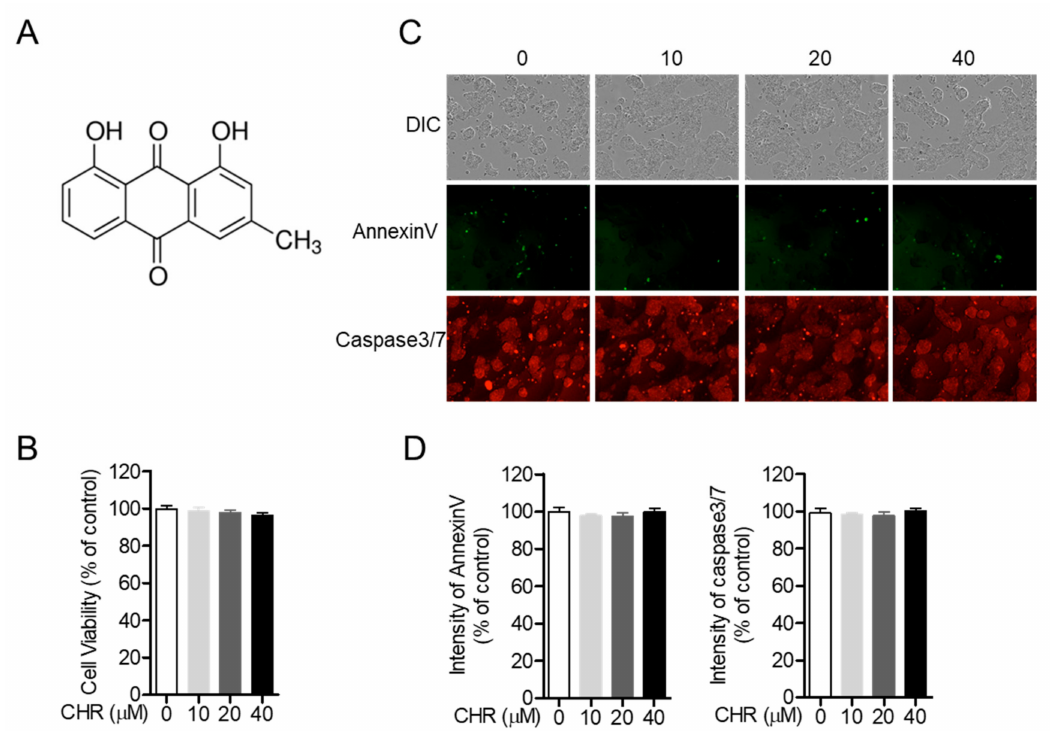
Figure 1. Chrysophanol (CHR) does not show cytotoxicity on HT-29 colorectal cells. ( A ) The chemical structure of chrysophanol. ( B ) HT-29 cells (1 × 10 4 /well, 96-well plate) were treated with the indicated concentrations of chrysophanol (0 to 40 µ M) for 24 h and methyl thiazol tetrazolium (MTT) assay was performed for determination of cell viability. ( C , D ) HT-29 cells (1 × 10 4 /well, 96-well plate) were treated with the indicated concentration (0 to 40 µ M) of chrysophanol for 24 h and the intensity of AnnexinV and Caspase3/7 was assessed by IncuCyte imaging system. Obtained cell images ( C ) and intensity of AnnexinV or Caspase3/7 is presented in bar graph (% of control). DIC; differential interference contrast. ( D ) The mean value of three experiments ± SEM is presented. SEM; standard error of the